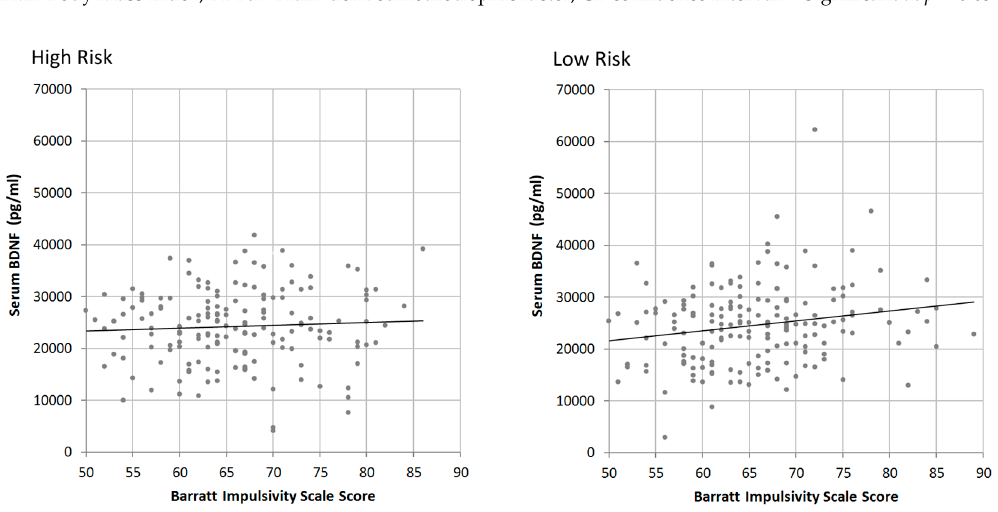
Figure 2. Scatter plot comparing serum BDNF (pg / µ L) and BIS score in high risk ( left , n = 117, beta = − 0.086, p = 0.361) and low risk ( right , n = 176, beta = 0.189, p = 0.014) populations.